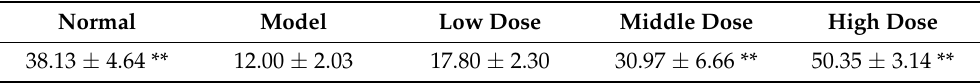
Table 3. The ACh levels in PC12 cells under different treatments ( µ g/mL, n =